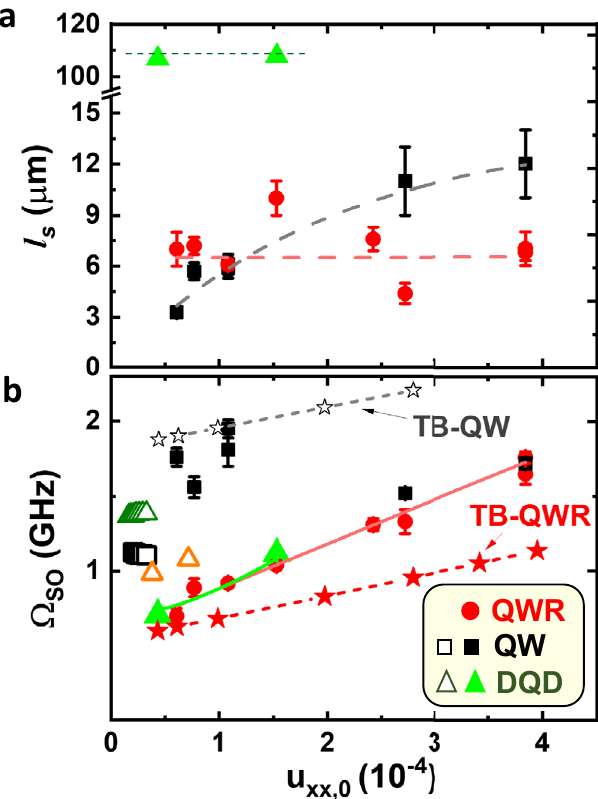
Fig. 4 | Spin dynamics under acoustic fi elds. a Spin transport length, ℓ s , and b angular precession frequency, Ω SO , asa function of the strain amplitude u xx ,0 for transport along the QW (10nm thick, black solid squares), QWR (red solid dots), and DQDs (30nm thick QW, green solid triangles) investigated in this work. The error bars represent the standard deviation in determining the fi tted parameters. The solid red line in ( b ) is a fi t of the QWR data to Eq. (2); the green curve super- imposedonthesolidtrianglesisthepredictionofEq.(3)fortheDQDsusingthe C 3 parameter determined from the fi t. Note that for the DQDs, the horizontal axis is the strain amplitude per acoustic beam and the Ω SO values were scaled by a factor ffiffiffi p of 1 = 2 to account for the higher transport velocity as compared to the QW or QWR(cf.Eqs.(2)and(3)).Theopenandsolid ⋆ 'syieldthe Ω SO obtainedfromtight- binding (TB) calculations for the studied QWs (TB-QW) and QWRs (TB-QWR), respectively. The dashedlines in ( a ) are guidesto the eye. The opensymbolsin( b ) represent previously reported data for spin transport by a single SAW 21 (series of open squares at u xx =0.2×10 − 4 ), DQDs in a 20nm thick QW 21 (series of open triangles at u xx =0.2×10 − 4 ), as well as for DQDs in a 20nm-thick QW 29 (orange